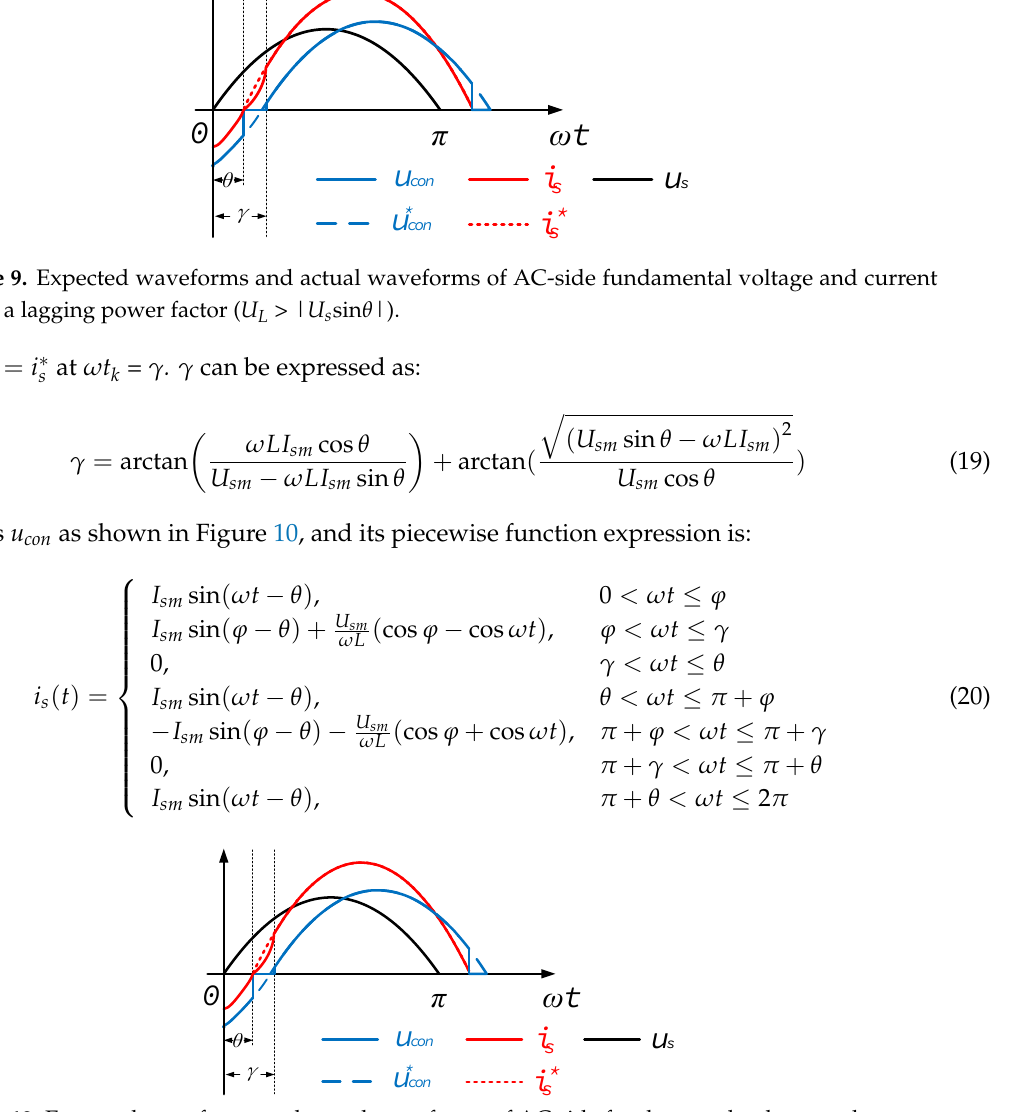
Figure 10. Expected waveforms and actual waveforms of AC side fundamental voltage and current under lagging power factor ( U L < | U s sin θ |).